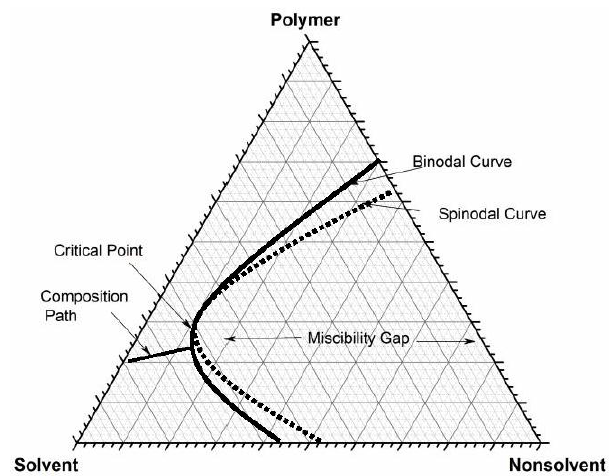
Figure 1. Theoretical composition path during phase inversion.